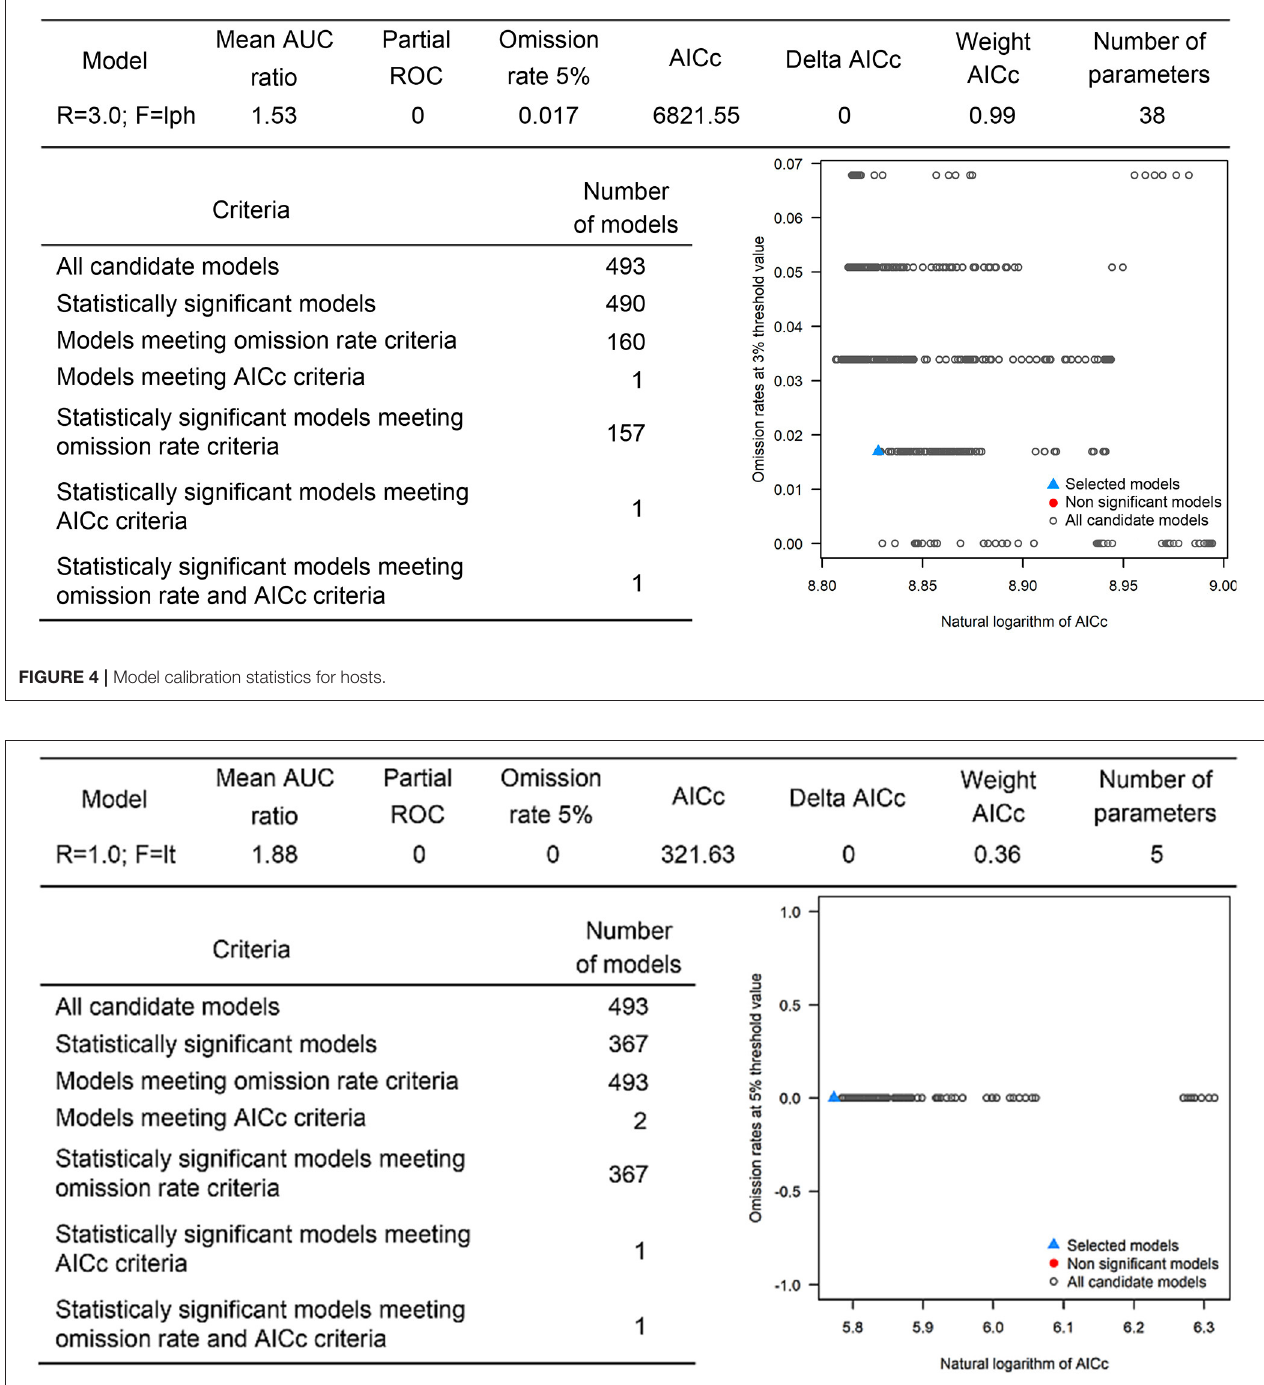
FIGURE 5 | Model calibration statistics for ticks.